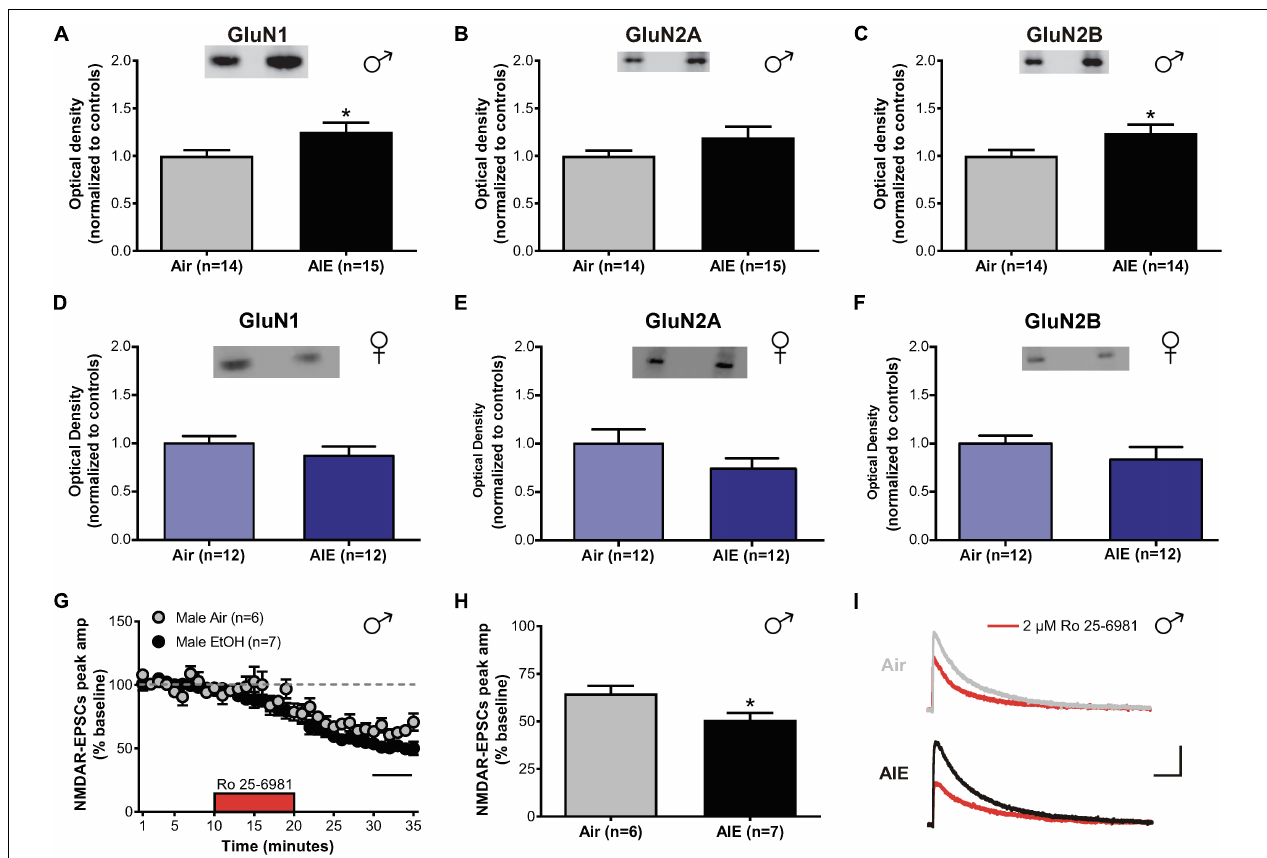
FIGURE 2 | NMDAR subunit expression and transmission in the dlBNST of male and female mice following acute withdrawal from AIE. Western blot analysis of GluN1 (A) , GluN2A (B) , GluN2B (C) subunit expression from air- and AIE-treated male and female mice (D–F) . Tissue was collected 5 h following the final vapor chamber exposure, during acute withdrawal. Mean ( ± SEM) optical density values for protein bands are shown as percent of the corresponding controls run in the same blot. Ro 25–6981 (2 µ M) was applied to dlBNST slices from adolescent mice exposed to chronic intermittent ethanol (AIE) or volatilized water (Air); evoked NMDAR-isolated EPSCs were then recorded. (G) Time course of NMDAR-EPSC peak amplitudes in Air- and AIE-treated groups during a 10-min application of Ro 25–6981. Data points are the mean ± SEM. (H) Inhibition of NMDAR currents by Ro 25–6981, determined by calculating the percentage change in EPSC amplitude from 5 min before Ro addition to 5 min of the peak drug effect (last 5 min of washout). (I) Representative traces of NMDAR-EPSCs recorded from mice exposed to Air (top) and AIE (bottom) before (gray and black traces, respectively) and after (red traces) application of Ro 25–6981; vertical scale bar = 100 pA, horizontal scale bar = 200 ms. Symbols indicate significant differences determined by unpaired t -tests; ∗ p < 0.05.